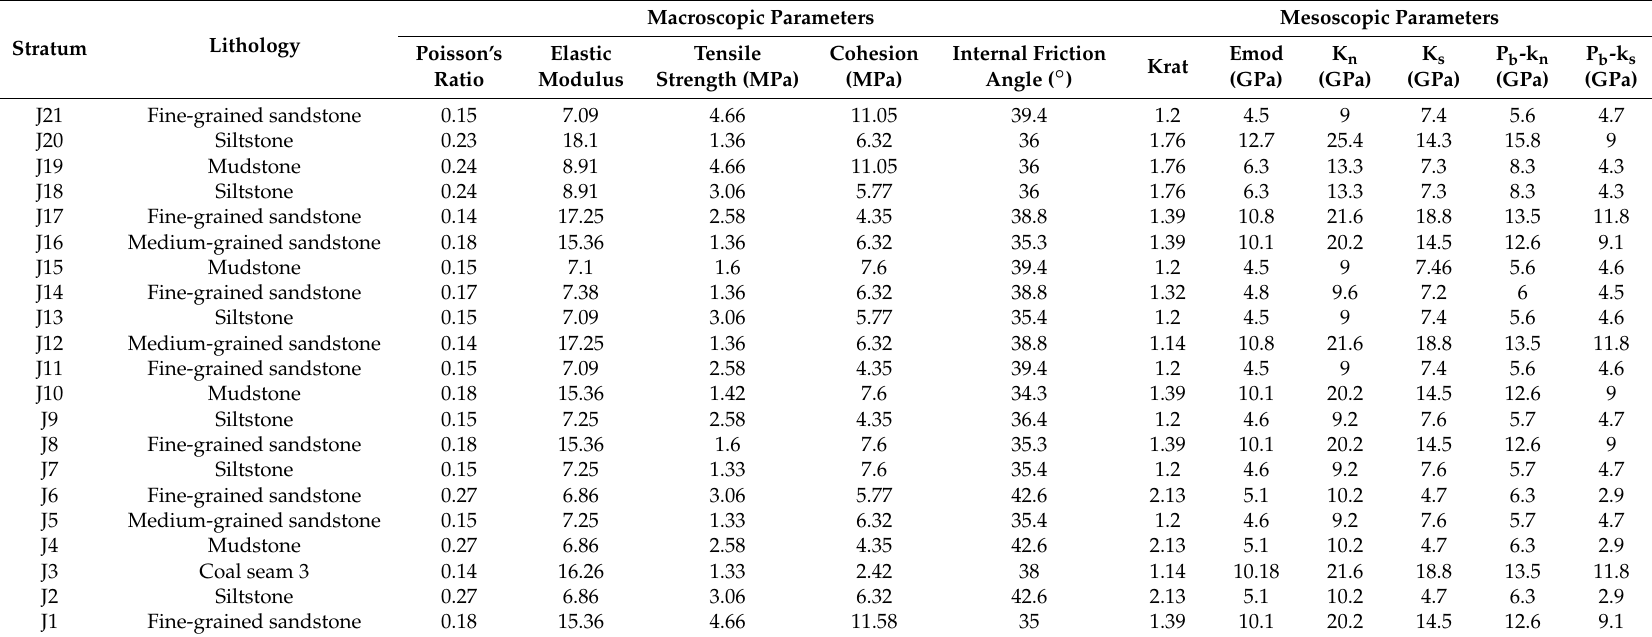
Table 1. Macroscopic and microscopic physic and mechanical parameters of No.6303 Face and its overly and underlying